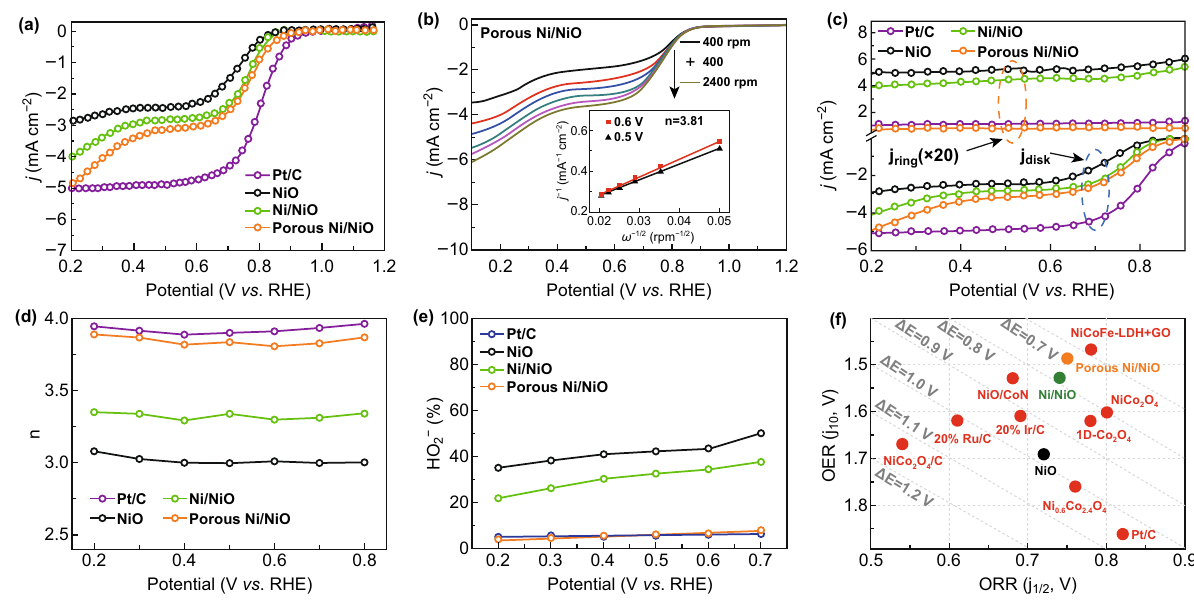
Fig. 4 a ORR curves for Pt/C, NiO, Ni/NiO, and porous Ni/NiO electrocatalysts. b ORR curves for porous Ni/NiO measured at different speeds; K – L plots obtained at different potentials are shown in the inset. c Disk and ring currents on RRDE with a ring potential of 1.5 V (vs. RHE). d Calculated n at different potentials, and e peroxide percentage for Pt/C, NiO, Ni/NiO, and porous Ni/NiO catalysts. f ORR and OER bifunctional activity of catalysts in this work compared with representative electrocatalysts in references (Δ E represents the typical